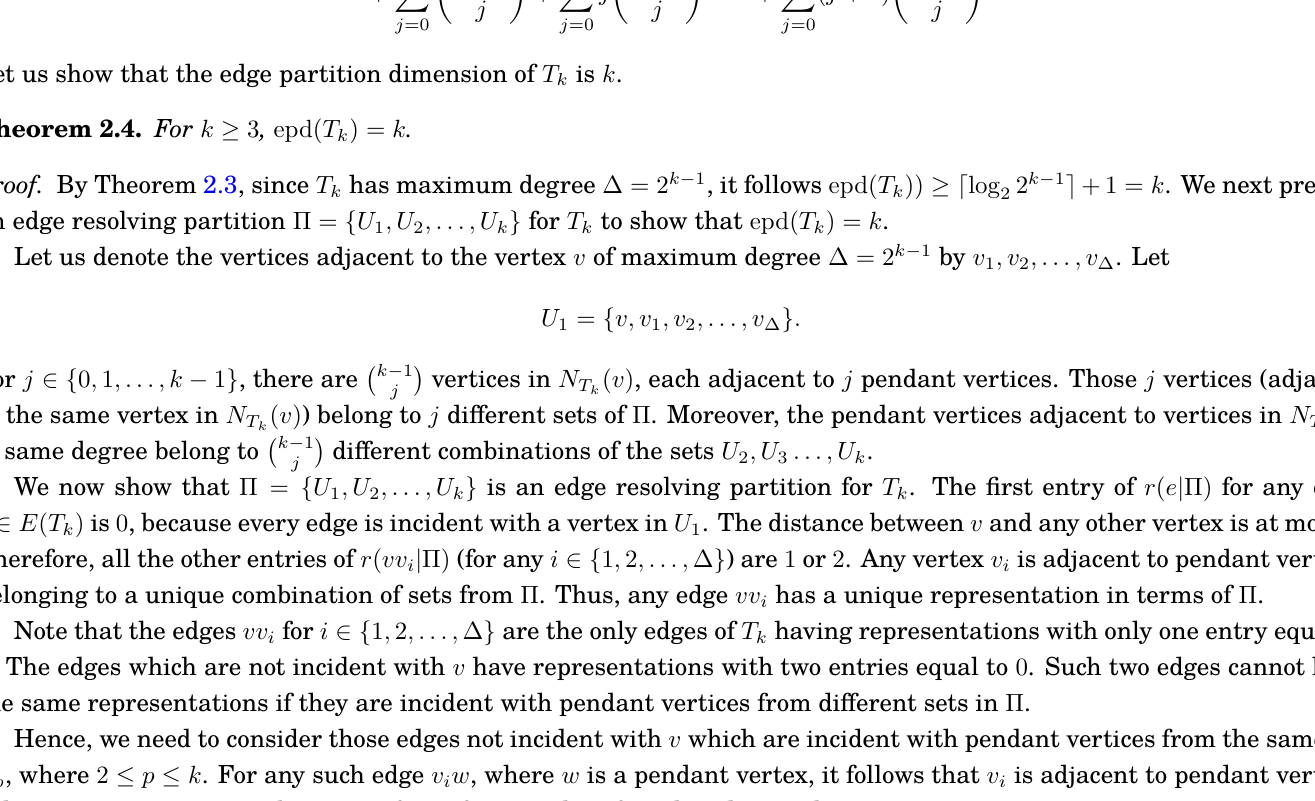
Figure 1: The tree T (vertices equally colored represent the set of an edge partition